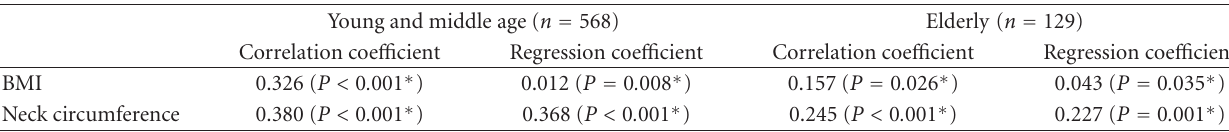
Table 3: Correlation coe ffi cients and results of stepwise multiple regression analysis between obesity-related variables and